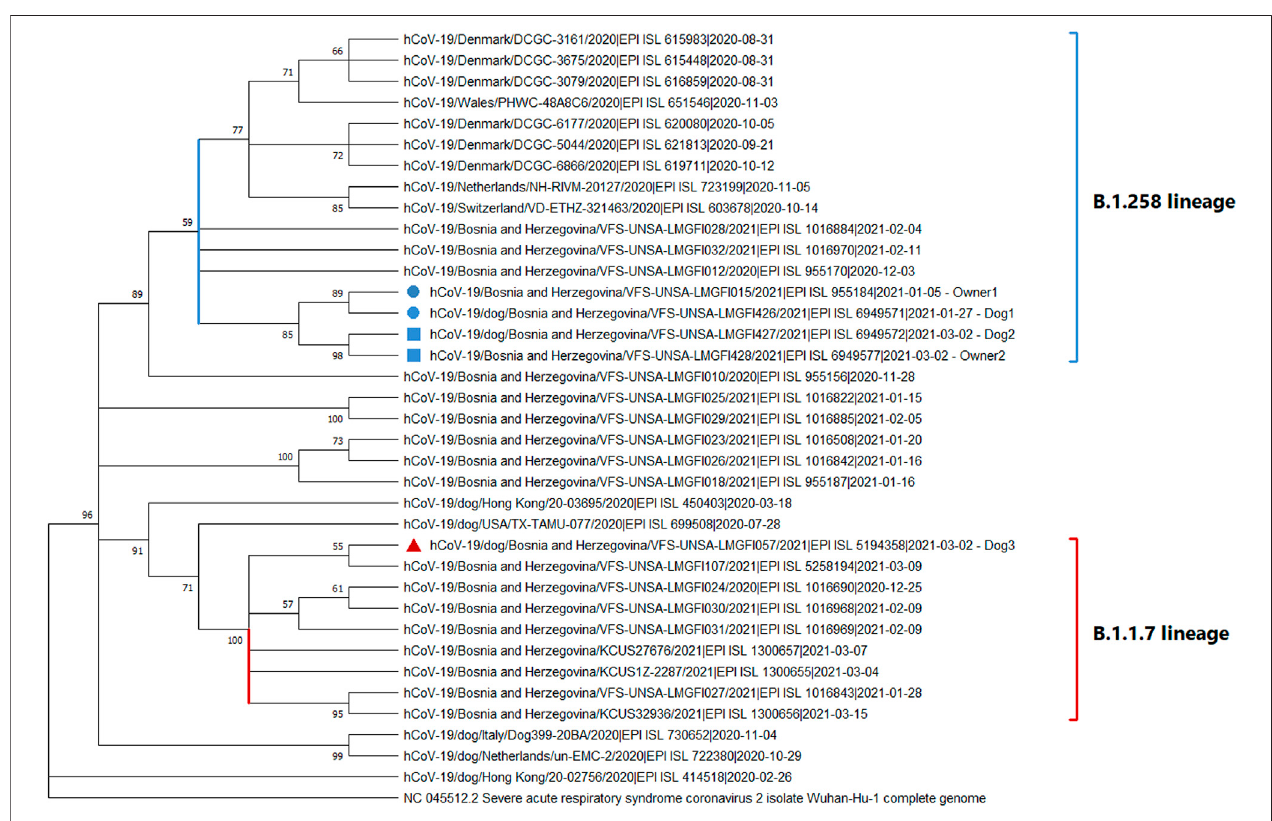
FIGURE 2 | A phylogenetic tree of SARS-CoV-2 showing the clustering of dog and owner virus sequences from Bosnia and Herzegovina. The positions of sequencesinthephylogenetictreeareshownwithabluecircleforDog1andOwner1andabluerectangleforDog2andOwner2togetherwithotherB.1.258sequences (blue bracket). The sequence of Dog3 is marked with a red triangle, and is found together with other B.1.1.7 sequences (red bracket).